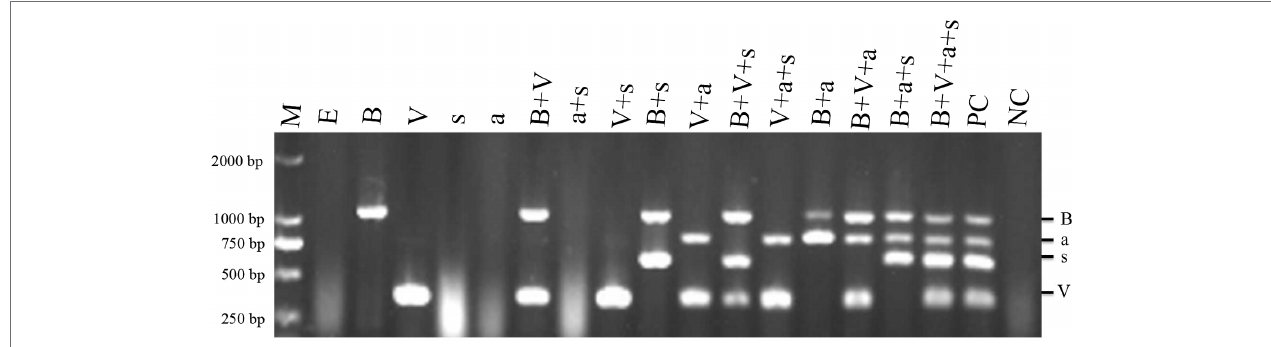
FIGURE 6 | RT-PCR detections of TBTD causal agents in the assayed Nicotiana benthamiana plants at 16 dpi. Lane M, DL 2000 DNA Marker; lane E, plants inoculated with pCB301; lane B, plants inoculated with TBTV-YK; lane V, plants inoculated with TVDV-YK, lane s, plants inoculated with TBTVsatRNA-YK; lane a, plants inoculated with TVDVaRNA-YK; lane B+V, plants inoculated with TVDV-YK+TBTV-YK, lane a+s, plants inoculated with TVDVaRNA-YK+TBTVsatRNA-YK; lane V+s, plants inoculated with TVDV-YK+TBTVsatRNA-YK; lane B+s, plants inoculated with TBTV-YK+TBTVsatRNA-YK; lane V+a, plants inoculated with TVDV- YK+TVDVaRNA-YK, lane V+B+s, plants inoculated with TVDV-YK+TBTV-YK+TBTVsatRNA-YK, lane V+a+s, plants inoculated with TVDV-YK+TVDVaRNA- YK+TBTVsatRNA-YK; lane B+a+s, plants inoculated with TBTV-YK+TVDVaRNA-YK+TBTVsatRNA-YK; lane V+B+a+s, plants inoculated with TVDV-YK+TBTV- YK+TVDVaRNA-YK+TBTVsatRNA-YK. PC, positive control; NC: negative control using healthy Nicotiana benthamiana plant